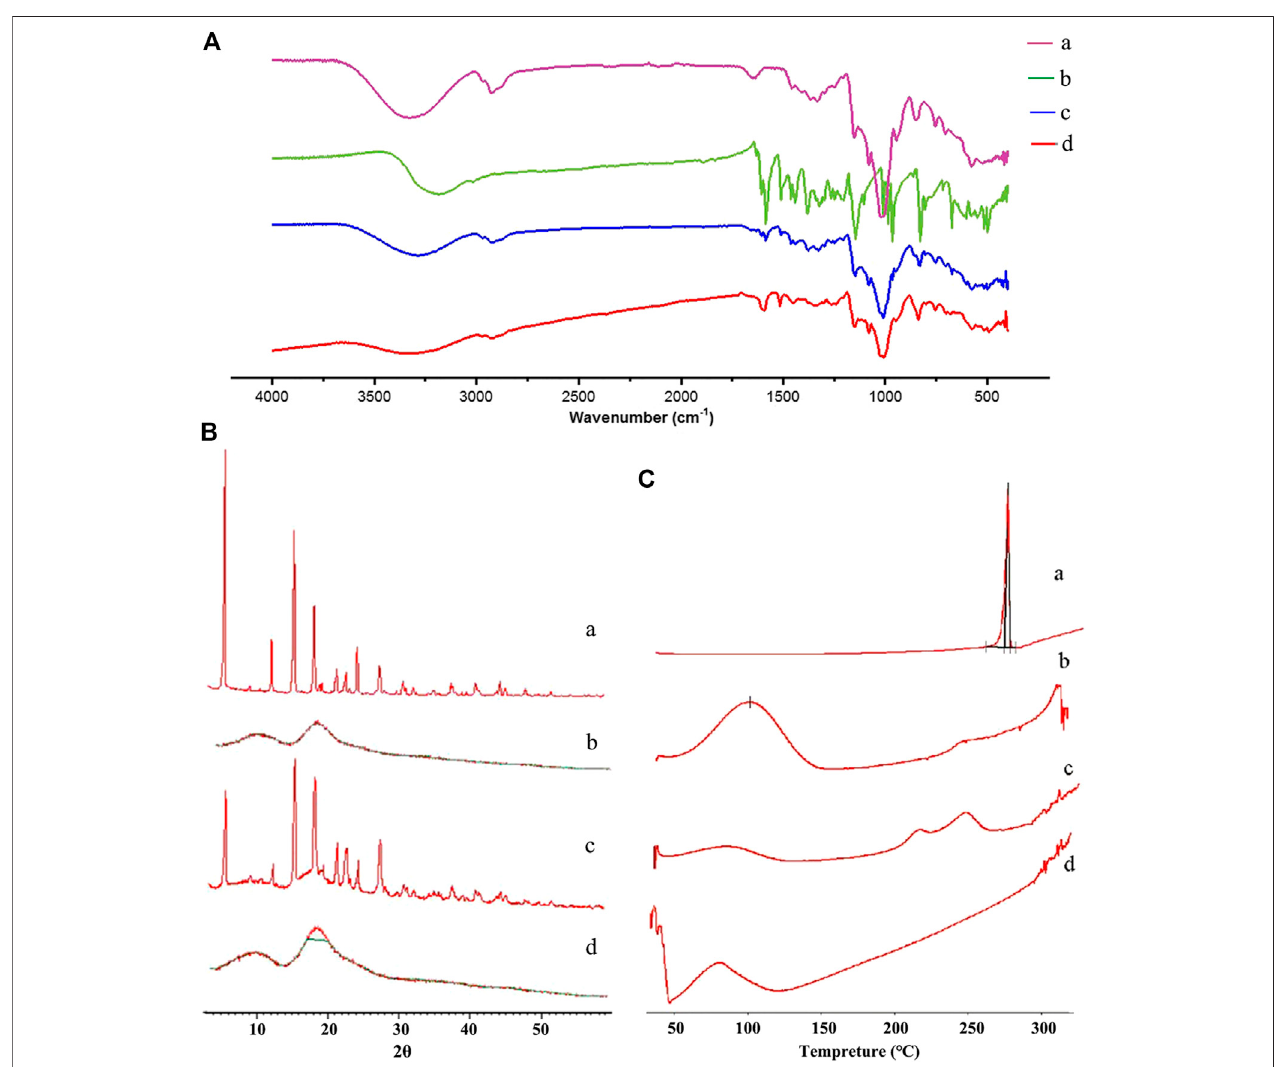
FIGURE 3 | FT-IR (A) , PXRD (B) , and DSC (C) spectra of RES (A) , HP- β -CD (B) , physical mixture (C) , and RHSD inclusion complex (D) .